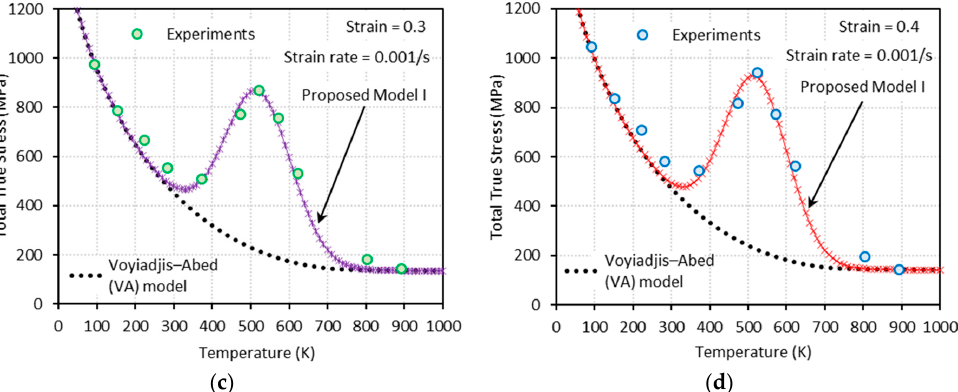
Figure 9. Comparisons between model predictions from the VA and proposed model I and experimental data from [1] on the total true stress versus temperature responses at ( a ) ε = 0.1, ( b ) ε = 0.2, ( c ) ε = 0.3, and ( d ) ε = 0.4. Quasi-static loading with 0.001 s − 1 is applied.